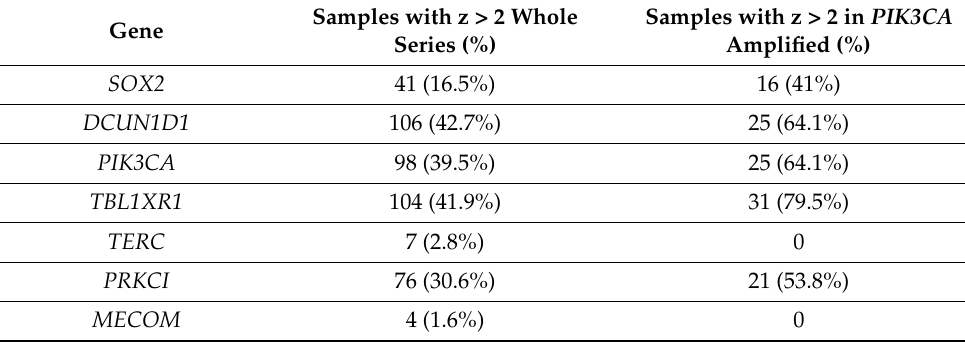
Table 3. Percentage of cases with mRNA expression z scores above 2 compared to diploid samples in all ( n = 248) and PIK3CA amplified ( n = 39) cervical squamous carcinomas. Data are from TCGA. Samples with z > 2 Whole Gene